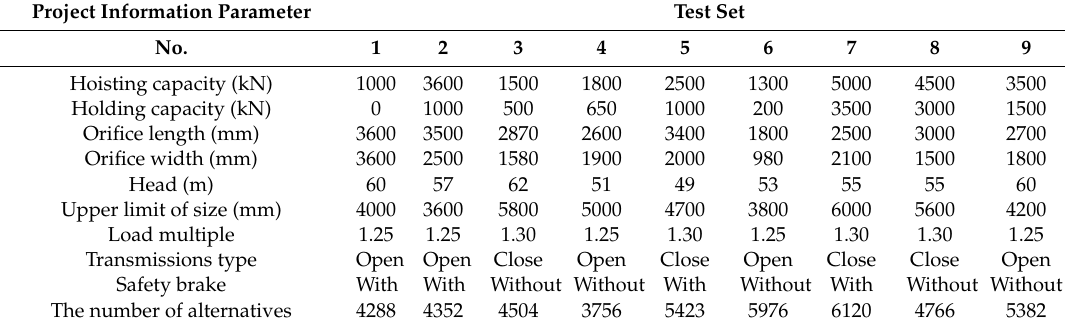
Table 5. Test set.